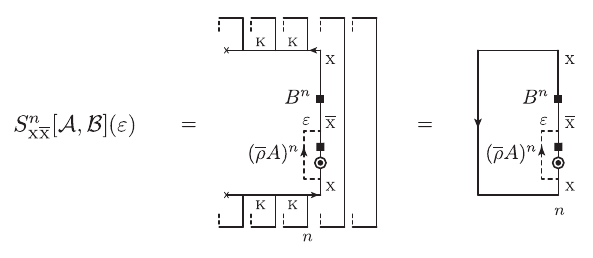
The depiction of Eq. (58) mimics the diagram for Eq. (47):